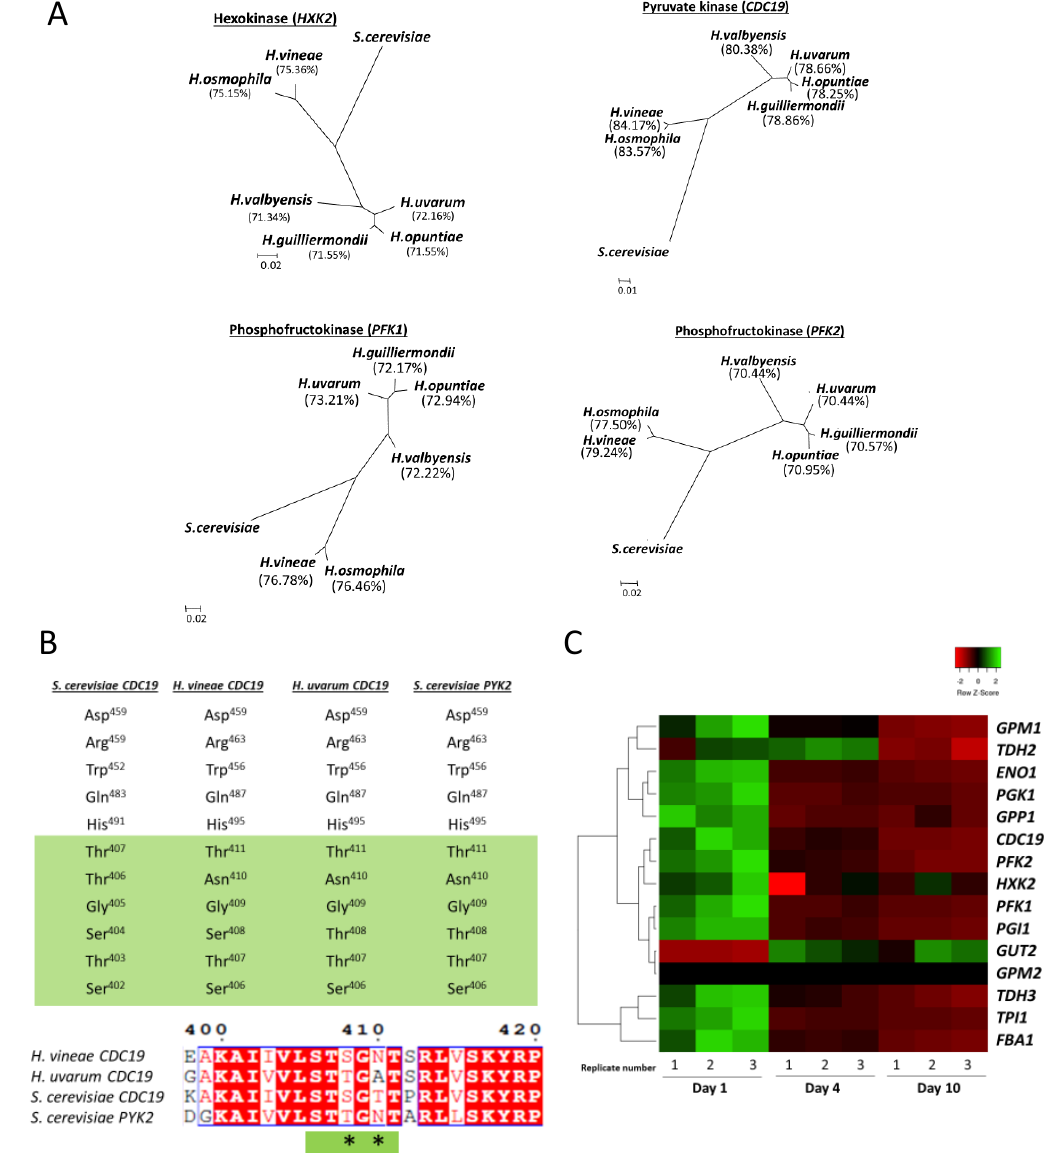
Figure 4. Genes involved in glycolysis. ( A ) Dendrograms showing the genetic distances between predicted amino acid sequences of enzymes involved in glycolysis from seven Hanseniaspora species and the Saccharomyces cerevisiae S288c strain. Amino acid homology was calculated for each Hanseniaspora strain against S. cerevisiae . ( B ) Amino acid sequences that correspond to the binding domains of fructose 1,6-bisphosphate inducer of pyruvate kinase in S. cerevisiae. Sc CDC19 and Sc PYK2 genes were compared with predicted sequences of CDC19 from H. uvarum and H. vineae . Amino acids corresponding to the region that differ from CDC19 and PYK2 are highlighted in green and the position of residues are marked with an asterisk (*). ( C ) A heatmap describing the expression levels of genes putatively determined to be involved in glycolytic pathways of H. vineae 1, 4, and 10 days after the initiation of fermentation. Green and red colours indicate high and low levels of expression, respectively. Data are shown in triplicate. Two copies of the S. cerevisiae Sc ENO1 gene that encodes an enolase were identified in H. osmophila , while only one copy was identified in other sequenced Hanseniaspora species. This enzyme catalyzes the conversion of 2-phosphoglycerate to phosphoenolpyruvate during glycolysis. Glyceraldehyde-3-phosphate dehydrogenase (GAPDH) is a tetramer that catalyzes the conversion of glyceraldehyde-3-phosphate to 1,3 bis-phosphoglycerate. Three unlinked genes, Sc TDH1 , Sc TDH2 ,